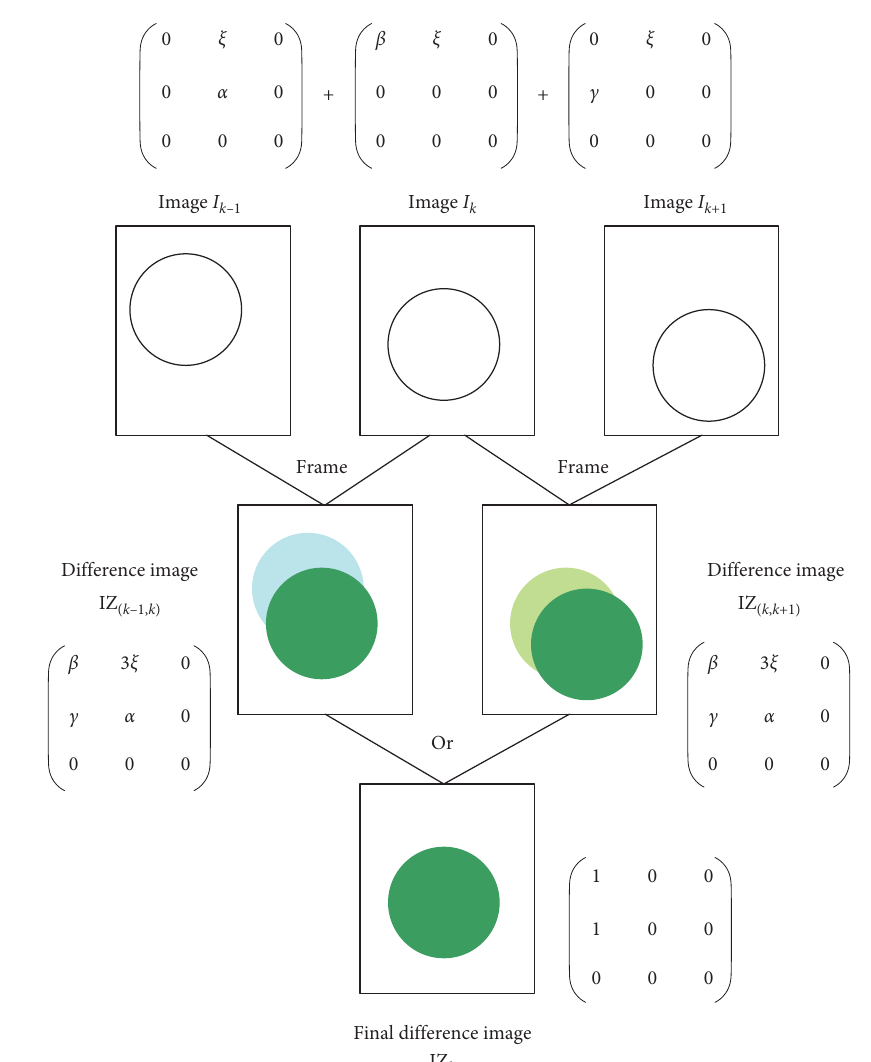
Figure 6: The schematic diagram of matrix transformation effect.